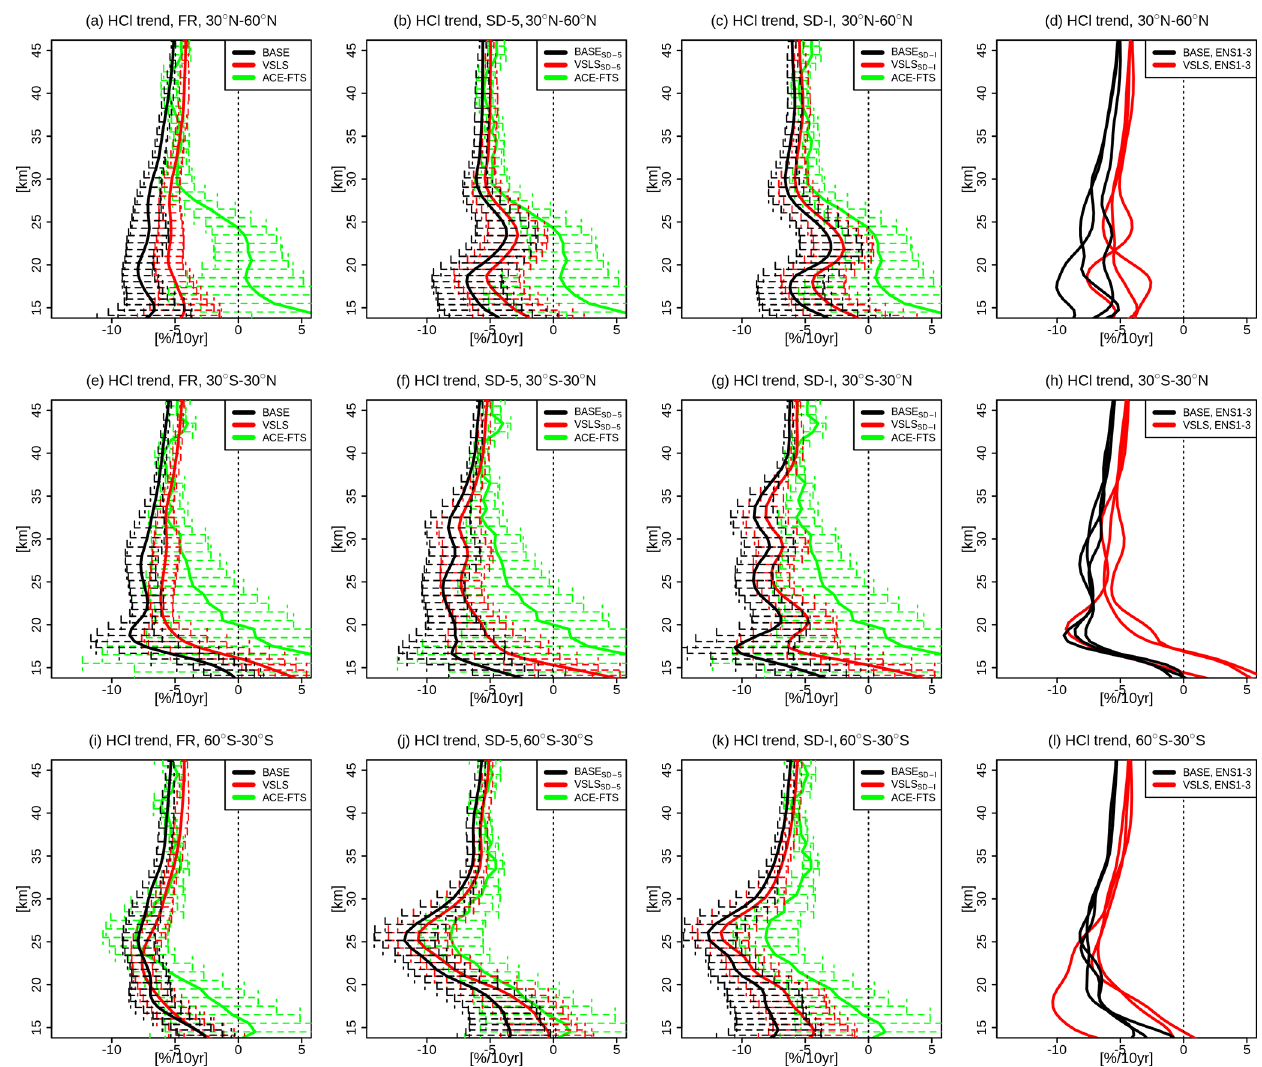
Figure 9. Linear trends in deseasonalised HCl mixing ratios [% per 10 years] averaged over (top) 30–60 ◦ N, (middle) 30 ◦ S–30 ◦ N and (bottom) 30–60 ◦ S. Left to right panels in each row are for: (a, e, i) the ensemble mean VSLS (red), ensemble mean BASE (black) and ACE-FTS (green); (b, f, j) VSLS SD-5 (red), BASE SD-5 (black) and ACE-FTS (green); (c, g, k) VSLS SD-I (red), BASE SD-I (black) and ACE-FTS (green); (d, h, l) the individual VSLS ensemble members (red) and the individual BASE ensemble members (black). Error bars indicate confidence intervals ( ± 2 standard errors); error bars are not plotted in (d, h, l) for